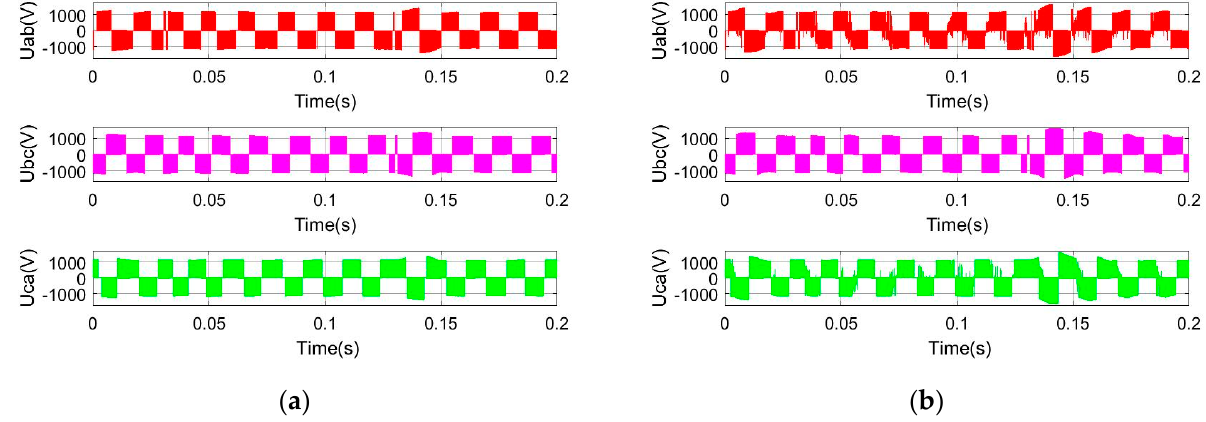
Figure 5. Simulated line-to-line voltage U abcg ( U ab , U bc , U ca ). ( a ) Normal state; ( b ) OC fault in T1.